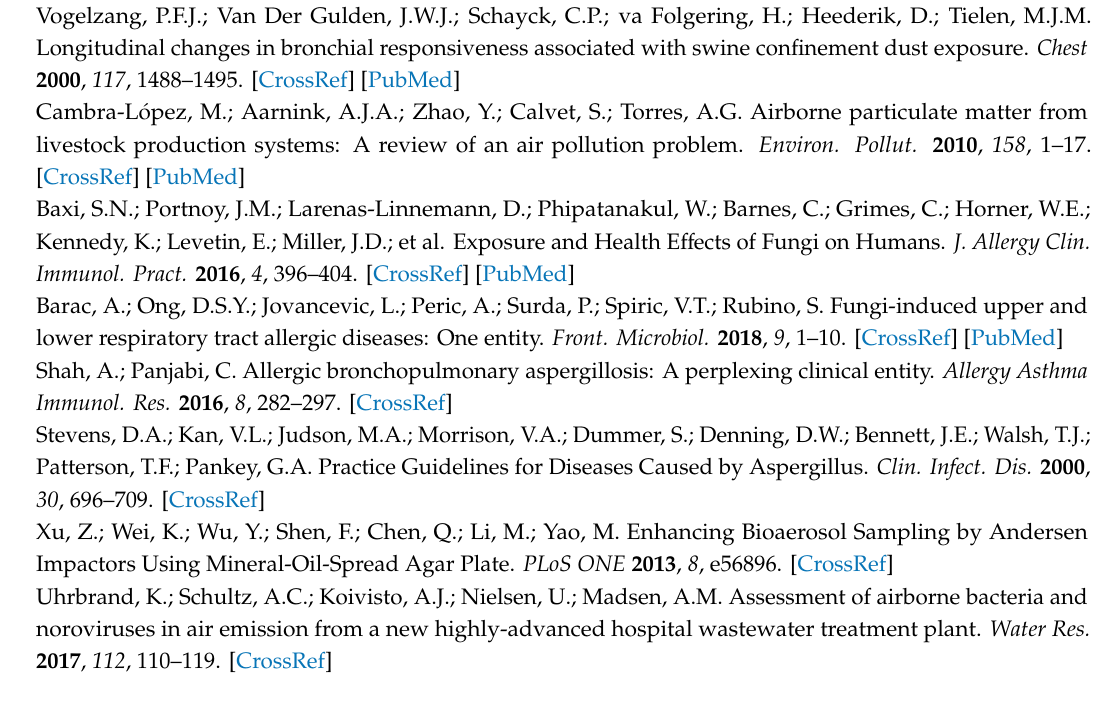
Figure S1. Species level richness for each of the six stages of the ACI-6 over the four sampling days. Figure S2. Rarefaction curve of the fungal reads per sample after sequencing of the glass fiber filter samples. Table S1. Genera which are shared and specific to samples which have or have not been treated with PMA. Samples which fall under the category “Untreated Samples” are those which are considered non-viable as their DNA was not amplified and detected after